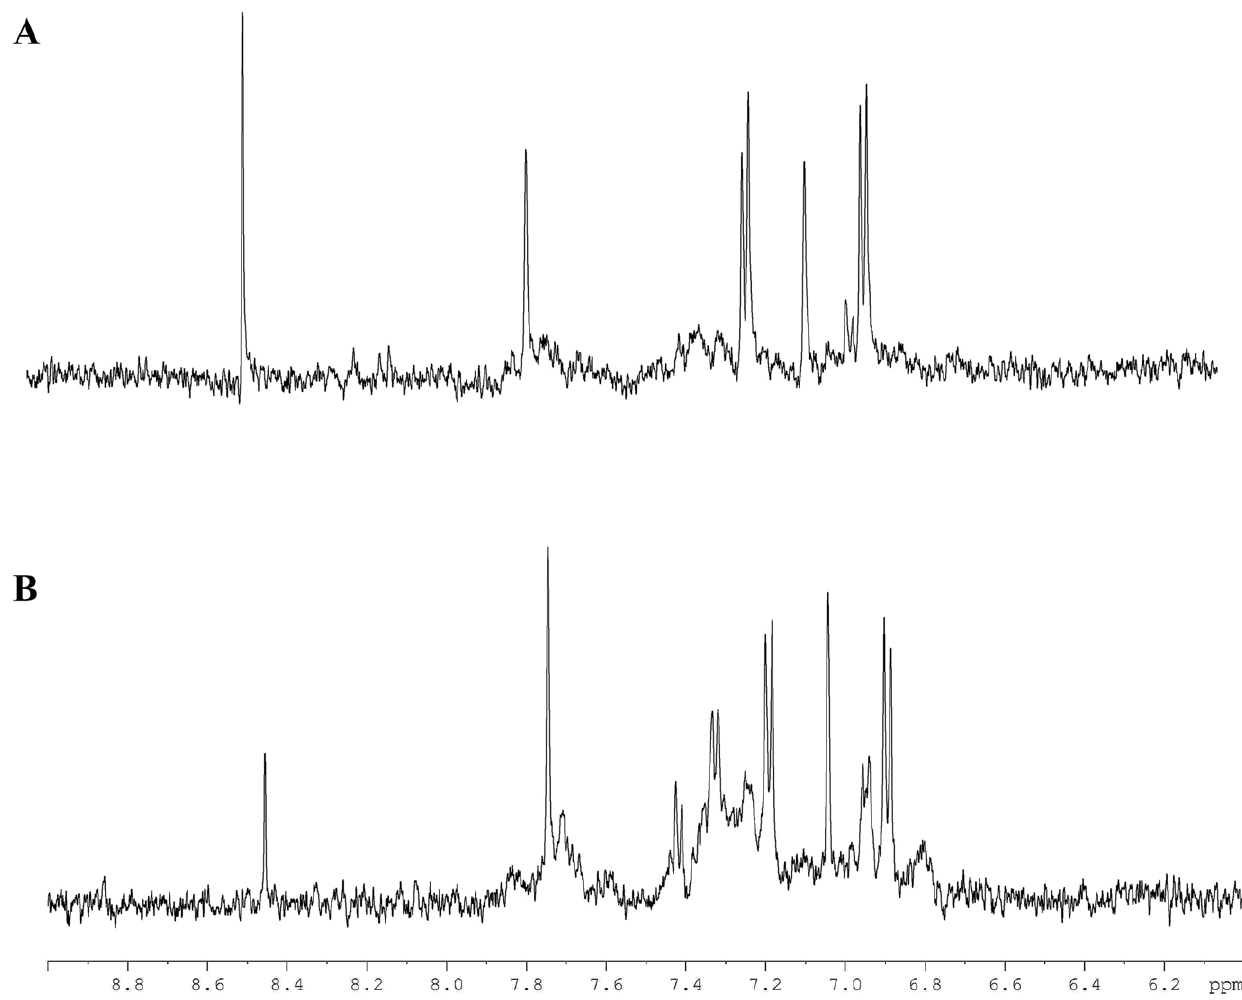
Figure 4. 500 MHz 1H NMR CPMG spectra for the aromatic region of blood plasma samples from a VLBW delivery. (A) Arterial cord blood, (B) Maternal blood. The maternal plasma shows signals at 6.80, 6.93, 7.23 and 7.68 ppm that are absent from the preterm plasma.